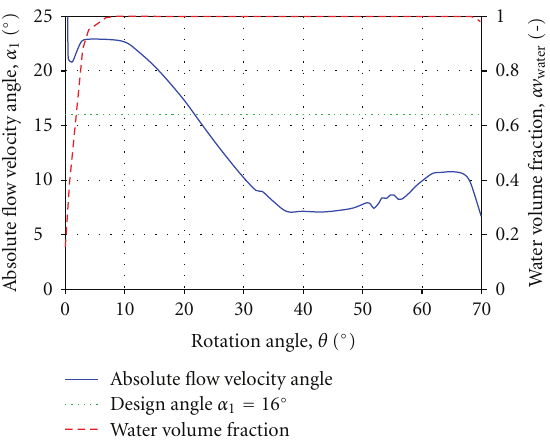
Figure 11: Comparison between numerical hydraulic e ffi ciency and experimental global e ffi ciency against runner